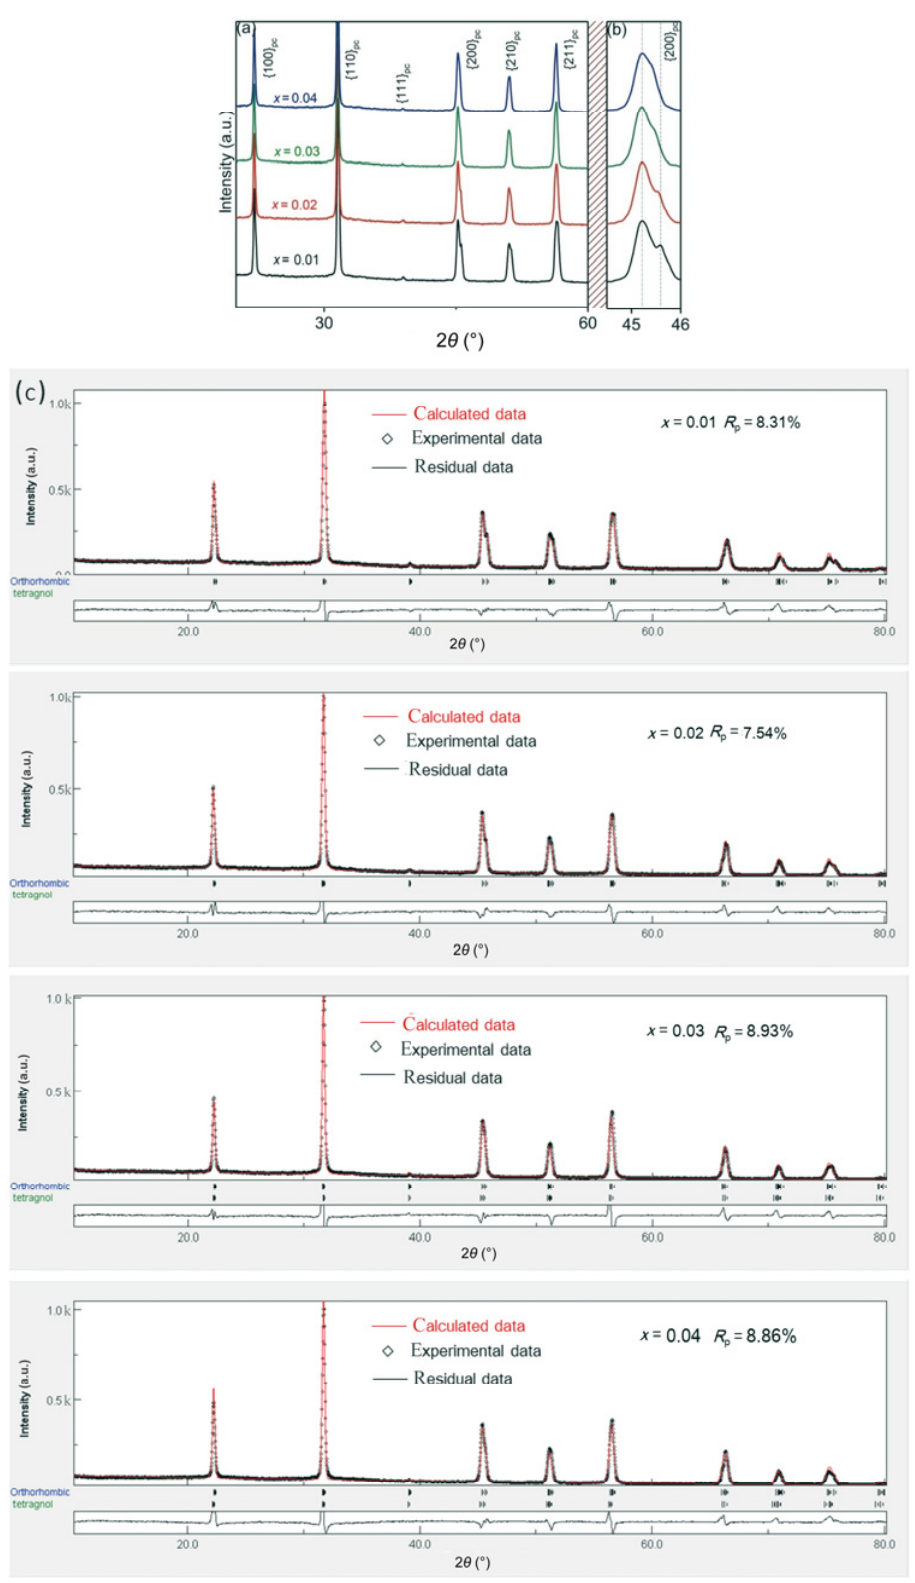
Fig. 2 (a) Room-temperature XRD patterns and (b) expanded XRD patterns in 2 θ range of 44.5°  46° of key peaks in LKNNS  EuNZ  x BZ ceramics; (c) Rietveld refinement of XRD patterns for LKNNS  EuNZ  x BZ ceramics where R p indicates the difference between the experimental and the theoretical